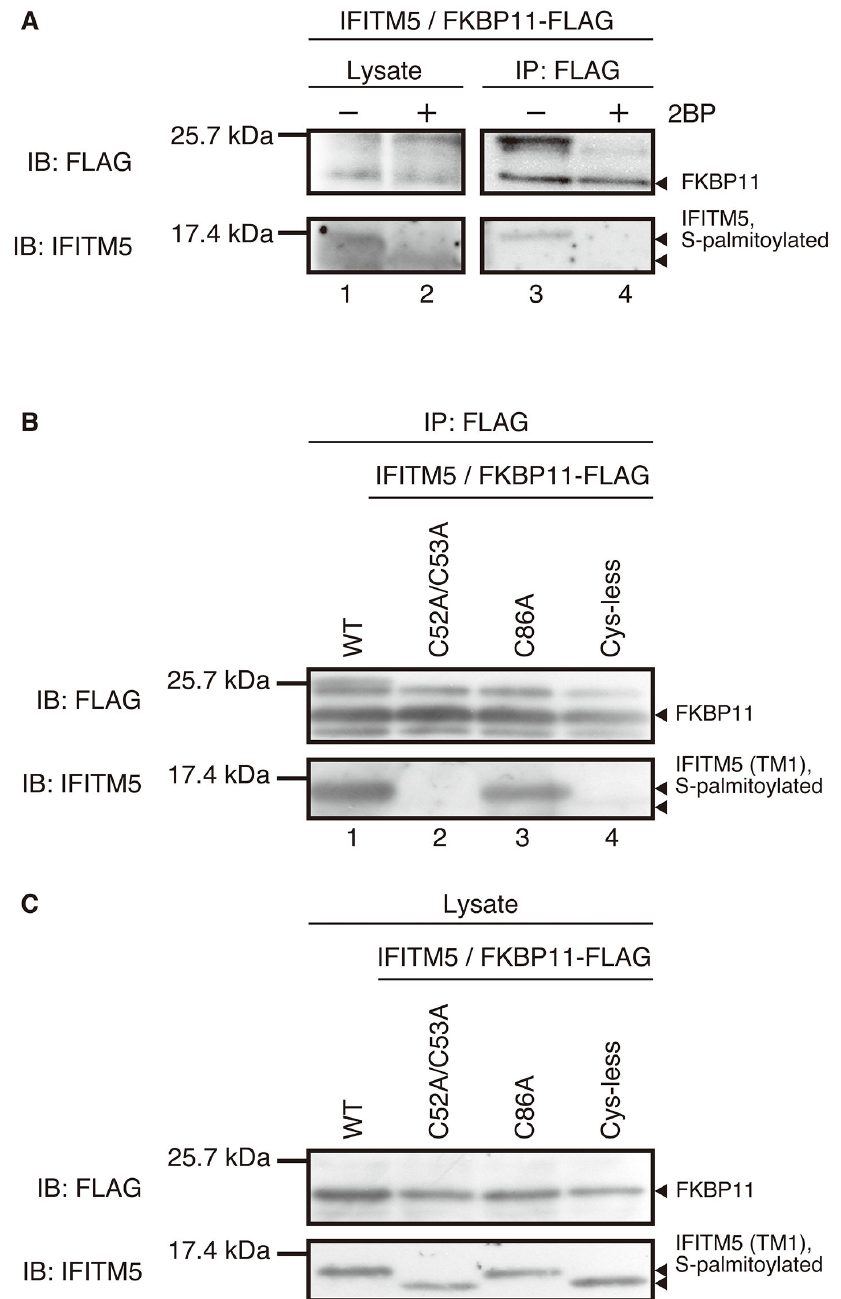
Figure 4. Western blot for detecting the interaction of IFITM5 with FKBP11. For detection of FKBP11-FLAG (upper panels) and IFITM5 (lower panels), the anti-FLAG and the anti-IFITM5 antibodies were used as primary antibodies, respectively. Arrows indicate the existence of each protein and the S-palmitoylation on IFITM5. A) Western blot for the co-immunoprecipitation of the wild-type IFITM5 with the FLAG-fused FKBP11 (FKBP11-FLAG) in the osteoblast cells in the absence and the presence of 2BP (denoted as “-” and “+”, respectively). Lanes 1 and 2 are the results for the control trials used to verify the existence of IFITM5 and FKBP11 before the immunoprecipitation, and Lanes 3 and 4 show the results after the immunoprecipitation. The experiment was repeated 3 times. B) Western blot for the co-immunoprecipitation of the wild-type and the cysteine-substituted mutants of IFITM5 with FKBP11-FLAG in the osteoblast cells. The band corresponding to FLAG peptide is not shown because of the smaller molecular-mass of FLAG peptide relative to FKBP11-FLAG. C) The control experiment of Figure 4-B used to verify that IFITM5 and FKBP11 were both present in the cell lysate before the immunoprecipitation. The experiment was repeated 2 times. doi: 10.1371/journal.pone.0075831.g004 PLOS ONE |